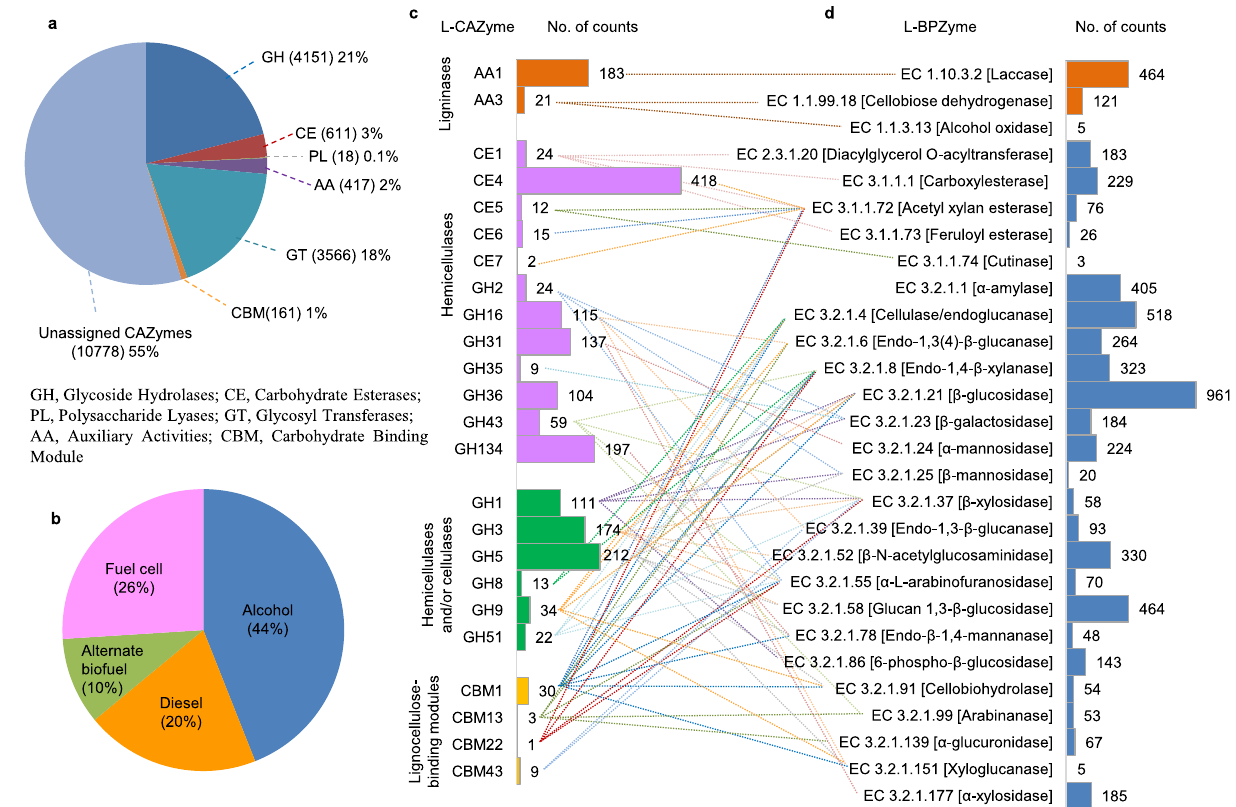
Figure 4. Lignocellulolytic enzymes predicted in emao based on carbohydrate-active enzymes (CAZymes) and biofuel producing enzymes (BPZymes) analyses. A complete list of CAZymes and BPZymes as recorded in emao is given in Supplementary Data Fig. S1 & S2, respectively. ( a) Pie chart indicating the percentage of CAZyme families assigned by Hotpep. The value within parentheses is the total count. ( b) Relative percentage of BPZyme categories as classified in BioFuelDB. ( c) Lignocellulolytic CAZyme sub-families segregated activity-wise. ( d) Lignocellulolytic BPZymes with Enzyme Commission (EC) number extracted from ( b) and correlated to ( c) (dotted